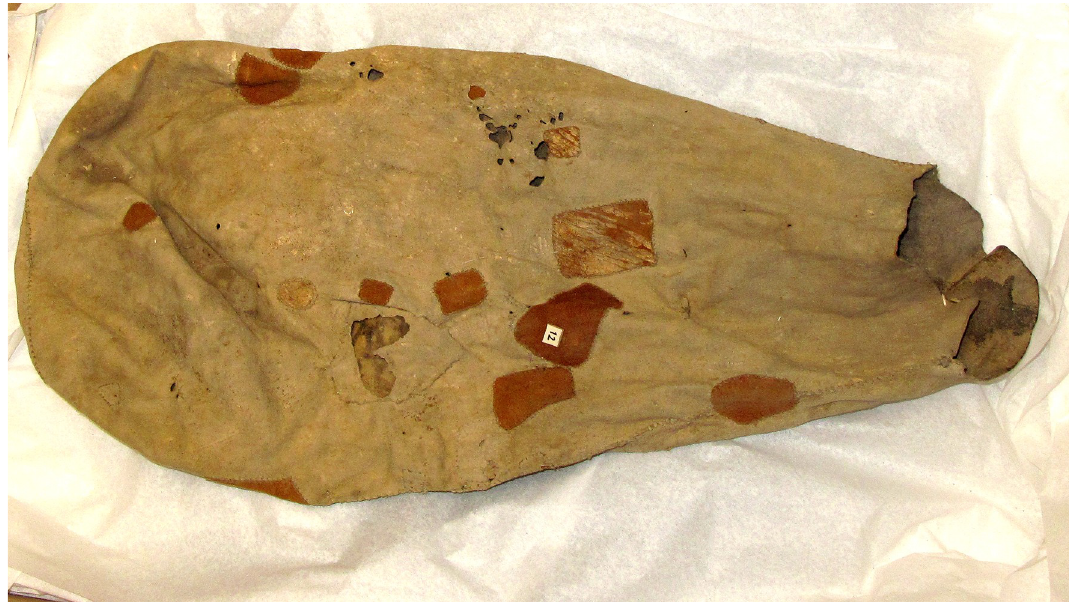
Fig 2. Examples of ethnographically recorded organic containers: A leather bag made by Ghanzi farm Bushmen, Botswana, 1973 (Unaccessioned, Russell and Russell Kalahari Collection, University of the Witwatersrand, South Africa) [42].